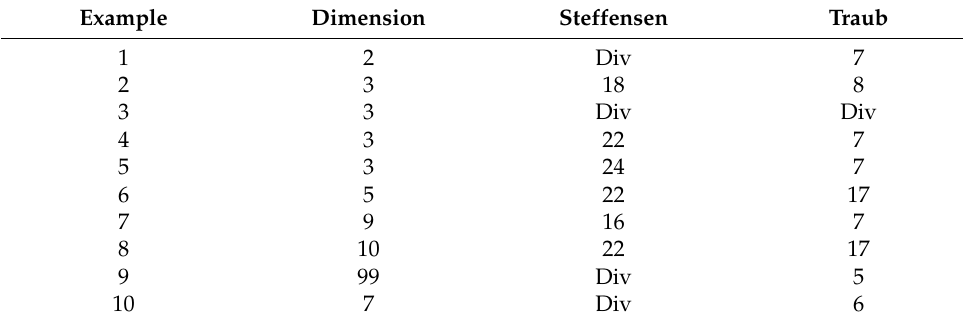
Table 1. Number of function evaluations used by each method for each